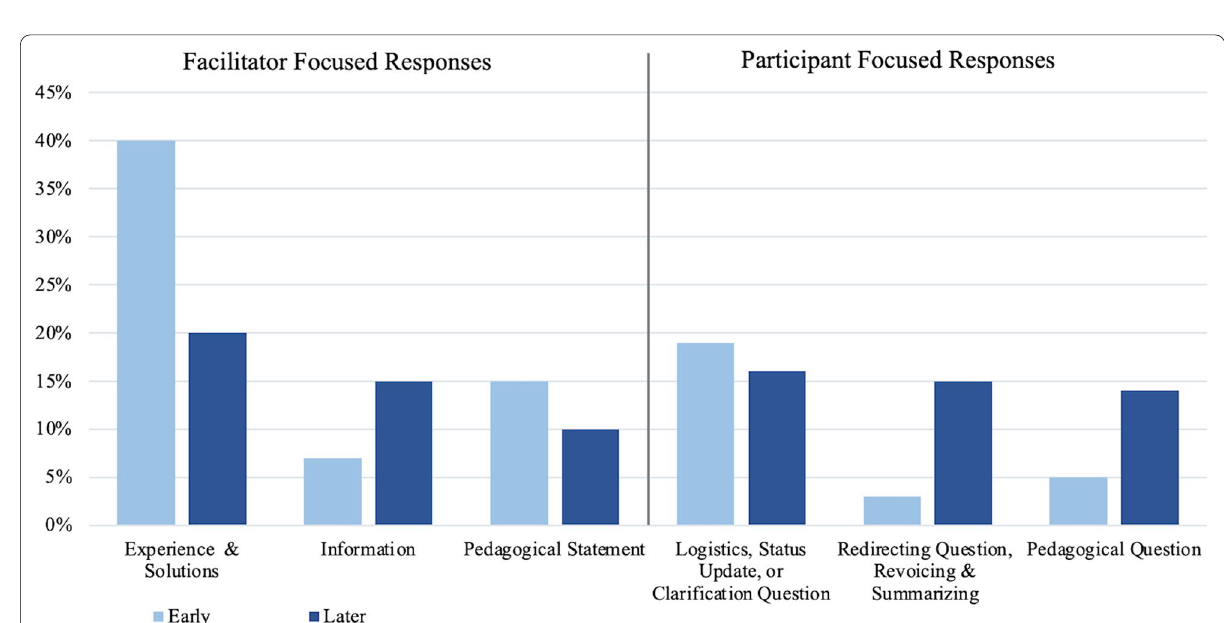
Fig. 5 Proportion of Participant Focused and Facilitator Focused subcodes in early and later meetings. For the early meetings, there was an average of 23 responses per meeting, averaging roughly 15 facilitator focused responses and 7 participant focused responses. For the later meetings there was an average of 20 responses per meeting, averaging roughly 9 facilitator focused and 9 participant focused responses. This graph does not include responses coded as